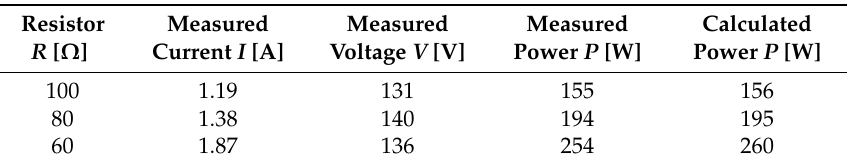
Table 1. Experimental result data for MPPT control.